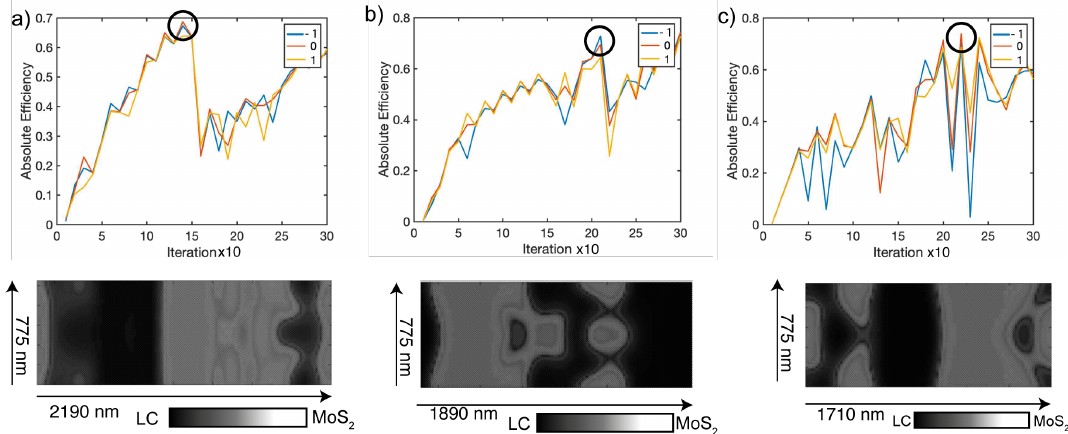
Figure 4. Illustration of the optimization steps for selecting the final structure pattern for the case ( a ) beam deflection of 45 ◦ using the n LC equal to 1.52 ( b ) beam deflection of 55 ◦ using the n LC equal to 1.72 and ( c ) beam deflection of 65 ◦ using the n LC equal to 1.92. For each case is reported the efficiency plot and the corresponding structures for the best case indicated by the black circle in each